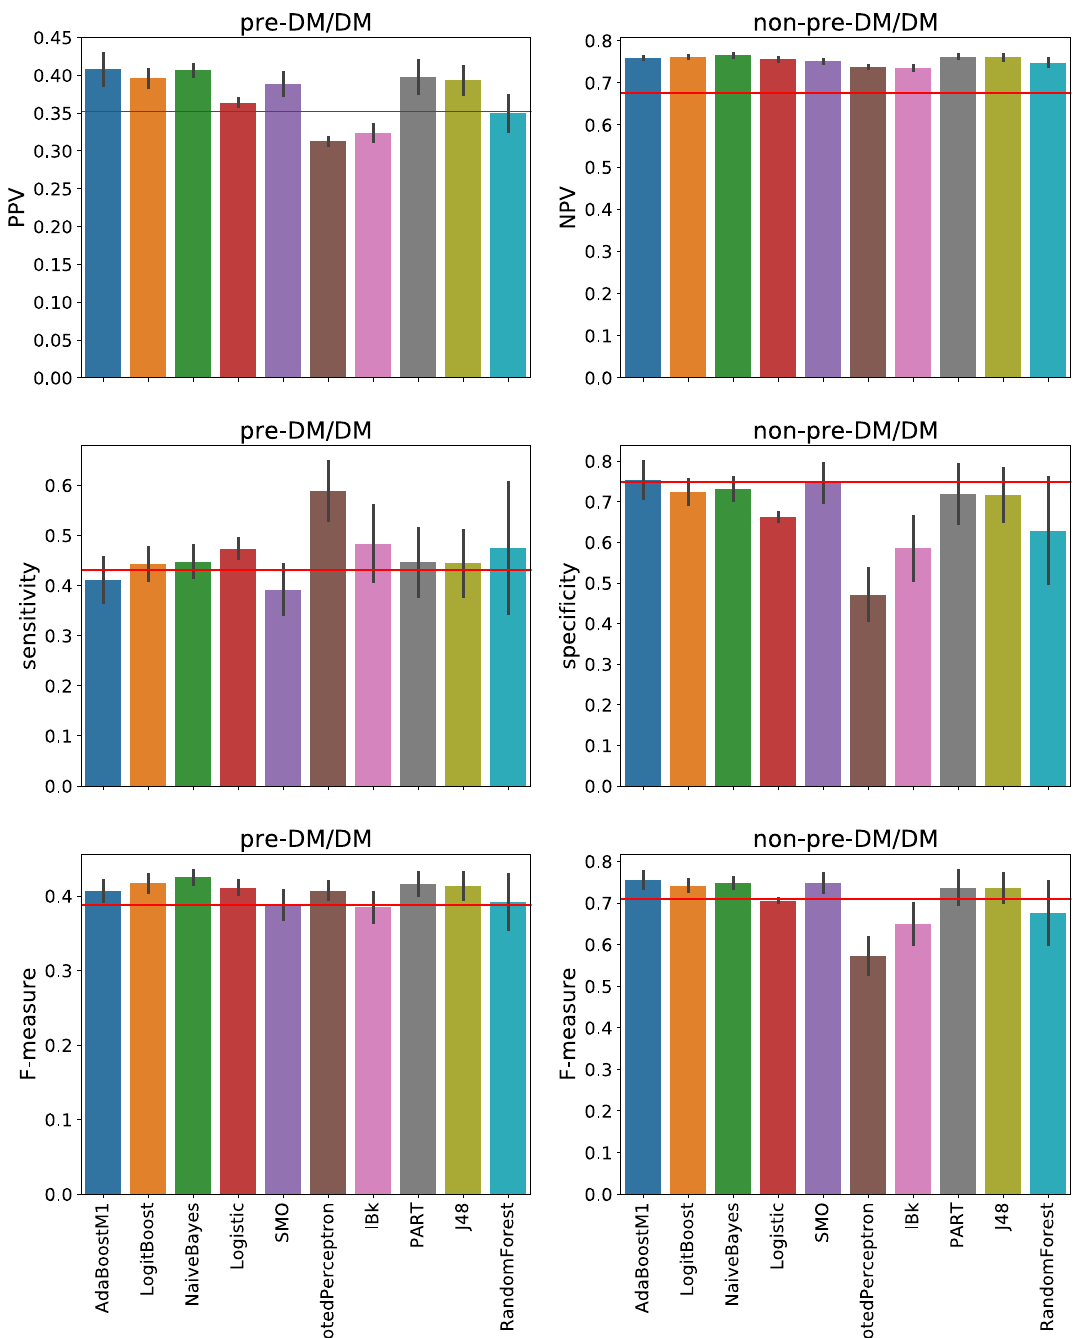
Figure 2. Performance of machine learning algorithms in classifying individuals into prediabetes/diabetes (preDM/DM) and non-preDM/DM classes, evaluated in terms of predictive value, sensitivity/specificity and F-measures for both classes. The variables used in this classification were the same as those used in the American Diabetes Association pediatric screening guidelines, whose performance in terms of each measure is shown by a horizontal red line in the corresponding subplot. preDM prediabetes; DM diabetes; PPV positive predictive value; NPV negative predictive